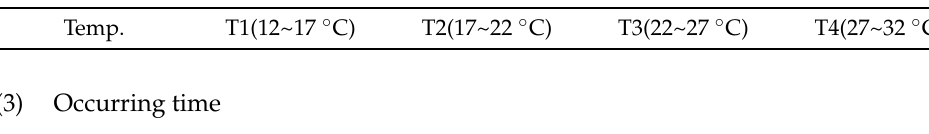
Table 4. Temperature groups.